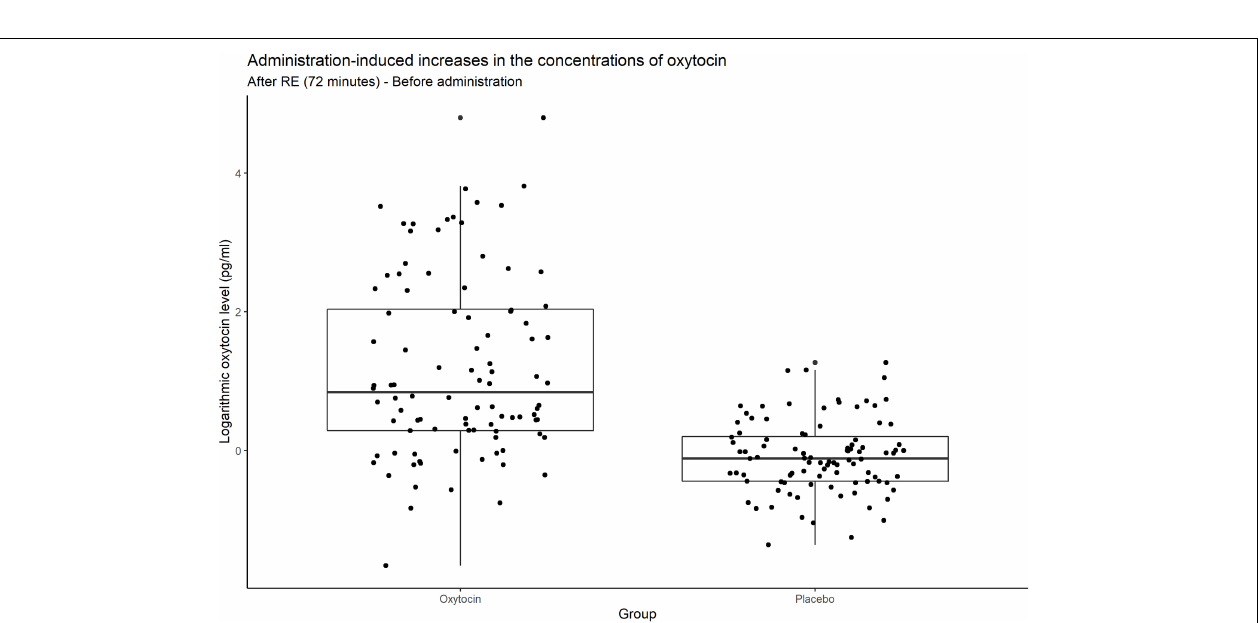
FIGURE 4 | Box plots of administration-induced increases in the concentrations of oxytocin. For each plot, the middle horizontal line denotes the median value; the box extends from the 25th to the 75th percentile values; the vertical lines extending from the box denote adjacent values (i.e., the most extreme values within 1.5 interquartile of the 25th and 75th percentile of each group); and the dots denote increases in the concentrations of oxytocin per investor from before administration to after the risk experiment. In the oxytocin group, the concentration of oxytocin surged in some participants, whereas there were small and even negligible increases in others. As expected, many participants in the placebo group exhibited almost no change in the concentration of oxytocin.